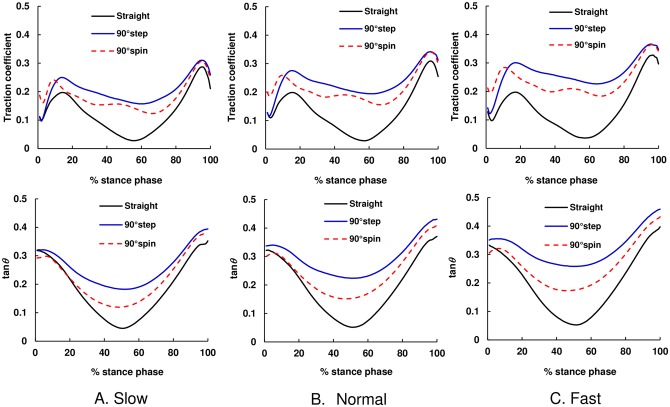
The average temporal pattern of mean values of the resultant traction coefficient and tangent of COM–COP angle during straight walking and turning.The black solid line shows straight walking, blue solid line shows 90° step turns, and red dashed line shows 90° spin turns. (A) Slow, (B) Normal, and (C) Fast.